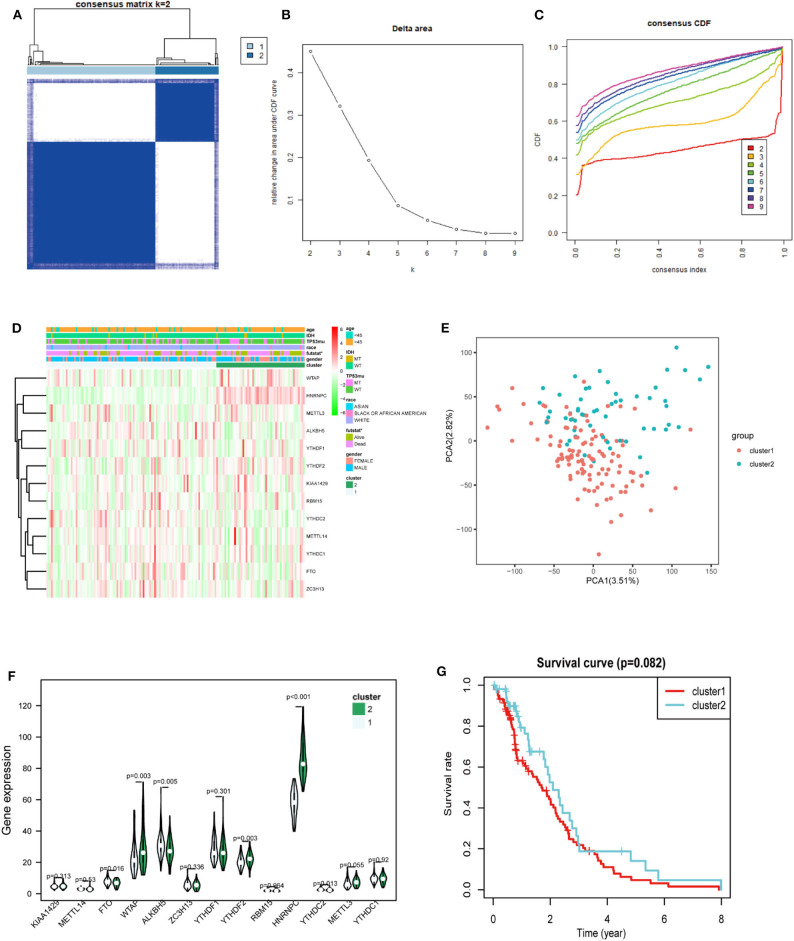
Differential expression and overall survival of GBM in the two subgroups. (A) The TCGA GBM cohort was divided into two clusters when k = 2. (B) Relative change in area under CDF curve for k = 2–9. (C) Consensus clustering cumulative distribution function (CDF) for k = 2–9. (D) The heatmap showed the relation between the two clusters and the clinical characteristic. (E) PCA (Principal component analysis) of the total RNA expression profile in GBM cluster1 was marked with red. (F) The violin chart of the two clusters (1 and 2) defined by the m6A RNA methylation regulators consensus expression (green represented the cluster 2) and position of white spots on the way represented the median value of expression. (G) Kaplan–Meier overall survival (OS) curves for GBM patients (p < 0.05 noted with *).